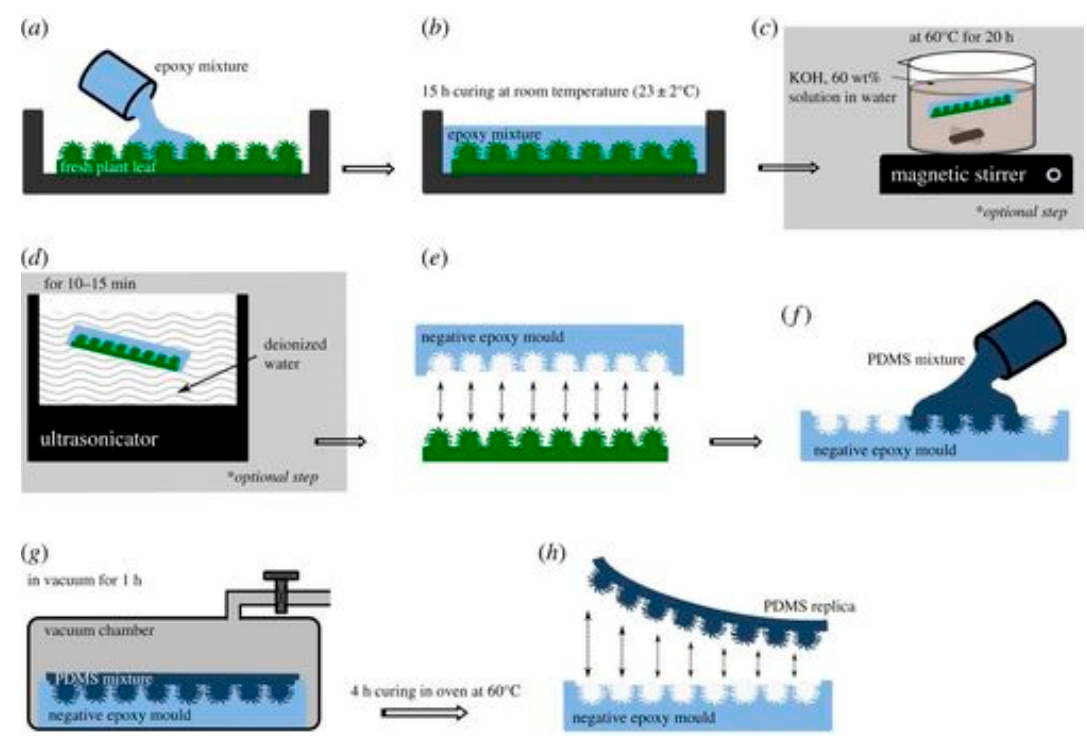
Figure 4. Schematic sketch of the two-step replication process: ( a ) Fresh plant leaf glued on a plastic Petri dish, filled up with epoxy resin. ( b ) Curing of epoxy mixture for 15 h to produce negative epoxy mould. ( c ) Epoxy sample (which adhered with leaf surface) is kept for chemical treatment in potassium hydroxide solution on magnetic stirrer (at 60 ± 3°C for 20 h). ( d ) Chemically treated sample washed in deionized water using an ultrasonicator. ( e ) Negative epoxy mould separated from the leaf surface. ( f ) Negative epoxy mould filled up with PDMS mixture. ( g ) Degassed in vacuum chamber to remove air trapped at the interface. ( h ) PDMS-positive replica peeled off from the epoxy mould. Reproduced with permission [9].